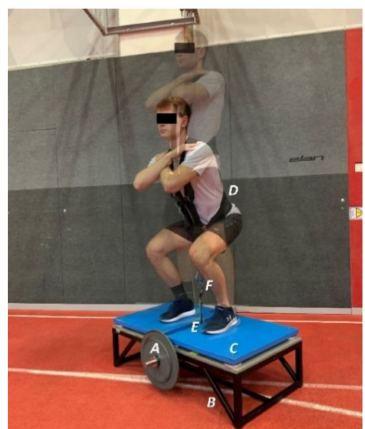
Figure 1. The structure of the flywheel device consisted of flywheels ( A ), standing platform ( B ) with two force plates ( C ) (each 0.50 m × 0.60 m), rotating shaft diameter (0.03 m), pulling rope (d = 0.006 m) and a harness ( D ). A linear encoder (draw-wire sensor) was installed under the device. The encoder string had its origin above the centre of the axis ( E ) and was attached to the harness (between the legs) ( F